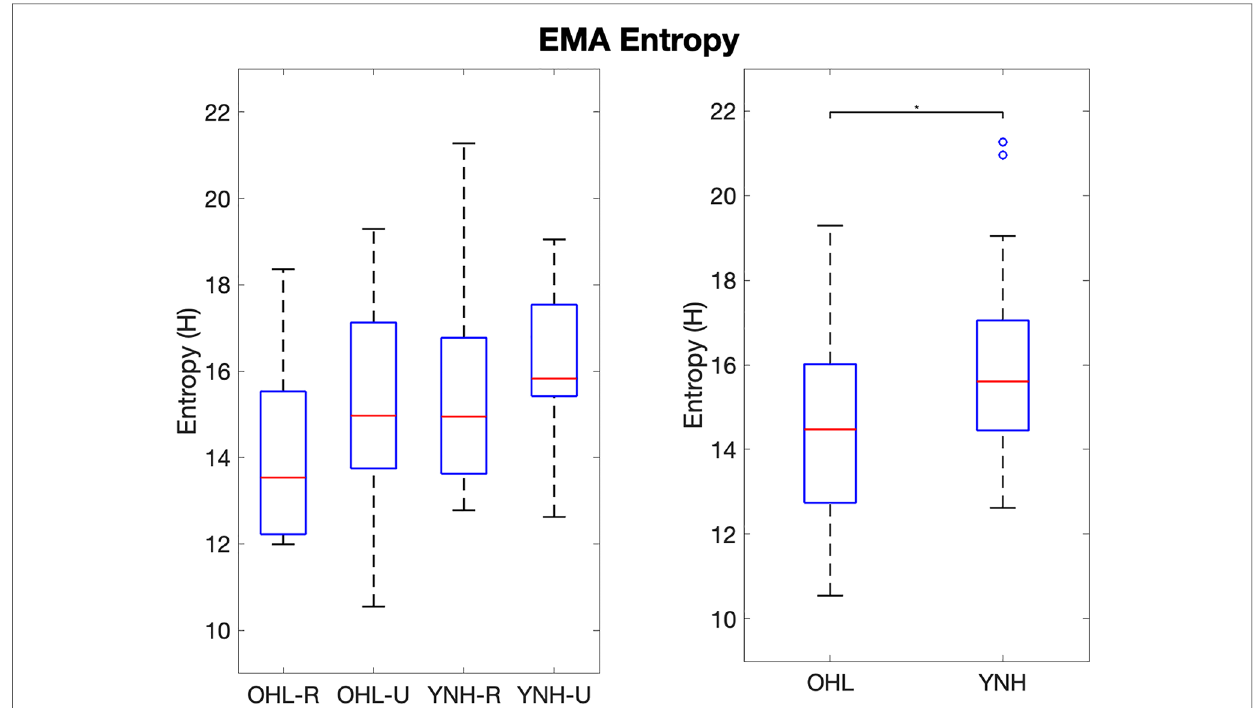
FIGURE 4 Boxplots of EMA entropy values per group (left) and groups combined along age and hearing status (right). OHL-R, older hearing loss rural; OHL-U, older hearing loss urban; YNH-R, younger normal hearing rural; YNH-U, younger normal hearing urban. OHL, older hearing loss (rural and urban combined); YNH, younger normal hearing (rural and urban combined). Vertical bars represent values within the fi rst and third quartiles þ = (cid:2) the interquartile range (cid:3) 1.5. Dots represent outliers. * indicates p , 0 : 05.